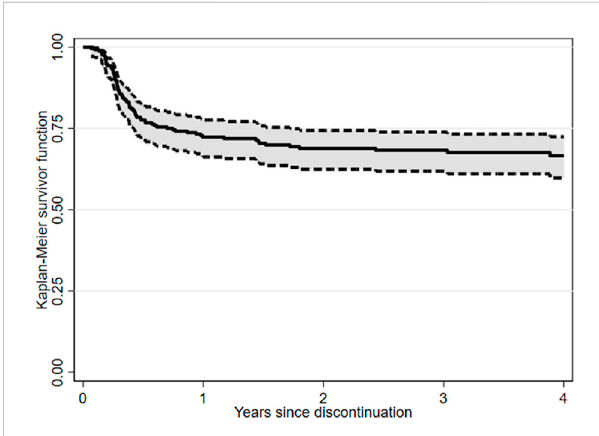
Treatment-free remission (TFR) after tyrosine kinase inhibitor (TKI) therapy (Kaplan-Meier survivor